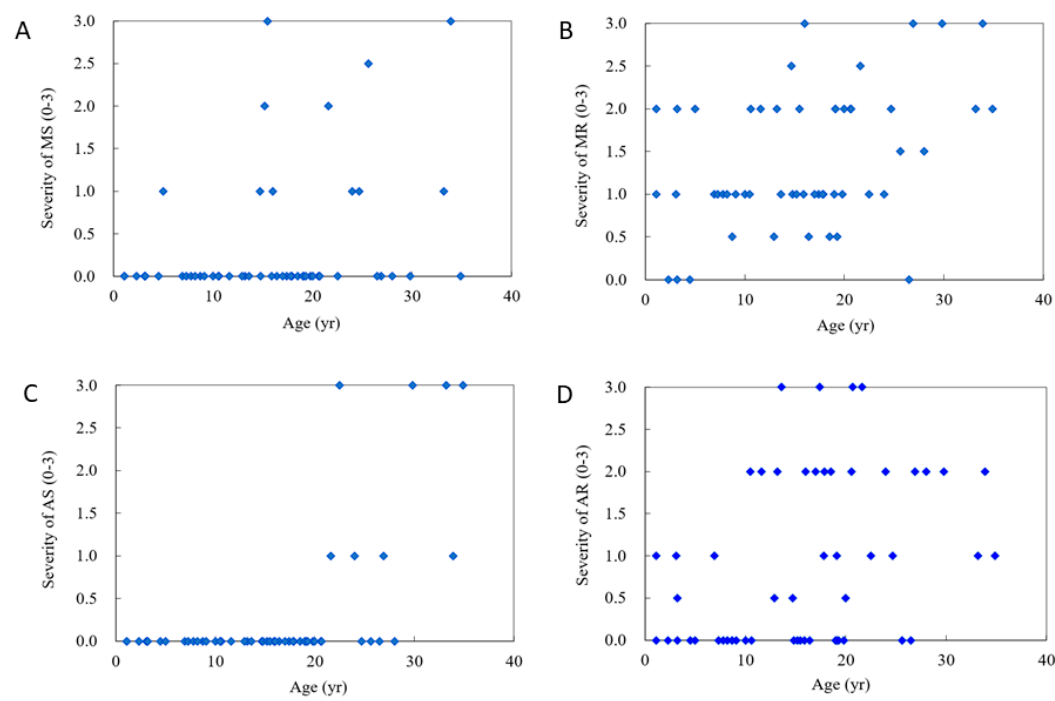
Figure 5. The relationships between age and severity of cardiac valve abnormalities in the 53 patients with mucopolysaccharidosis (severity score: 3: severe, 2: moderate, 1: mild, 0: normal). ( A ) MS, mitral stenosis ( r = 0.314, p < 0.05); ( B ) MR, mitral regurgitation ( r = 0.410, p < 0.01); ( C ) AS, aortic stenosis ( r = 0.579, p < 0.01); ( D ) AR, aortic regurgitation ( r = 0.371, p < 0.01). The blue dot represents the value of age and severity of cardiac valve abnormalities in the 53 patients.